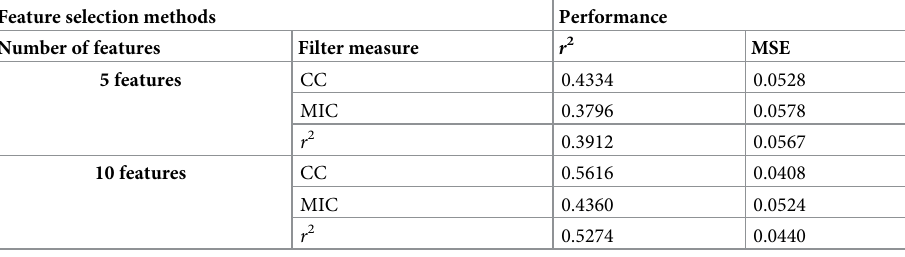
Table 8. Average performance for NNR models built by filter